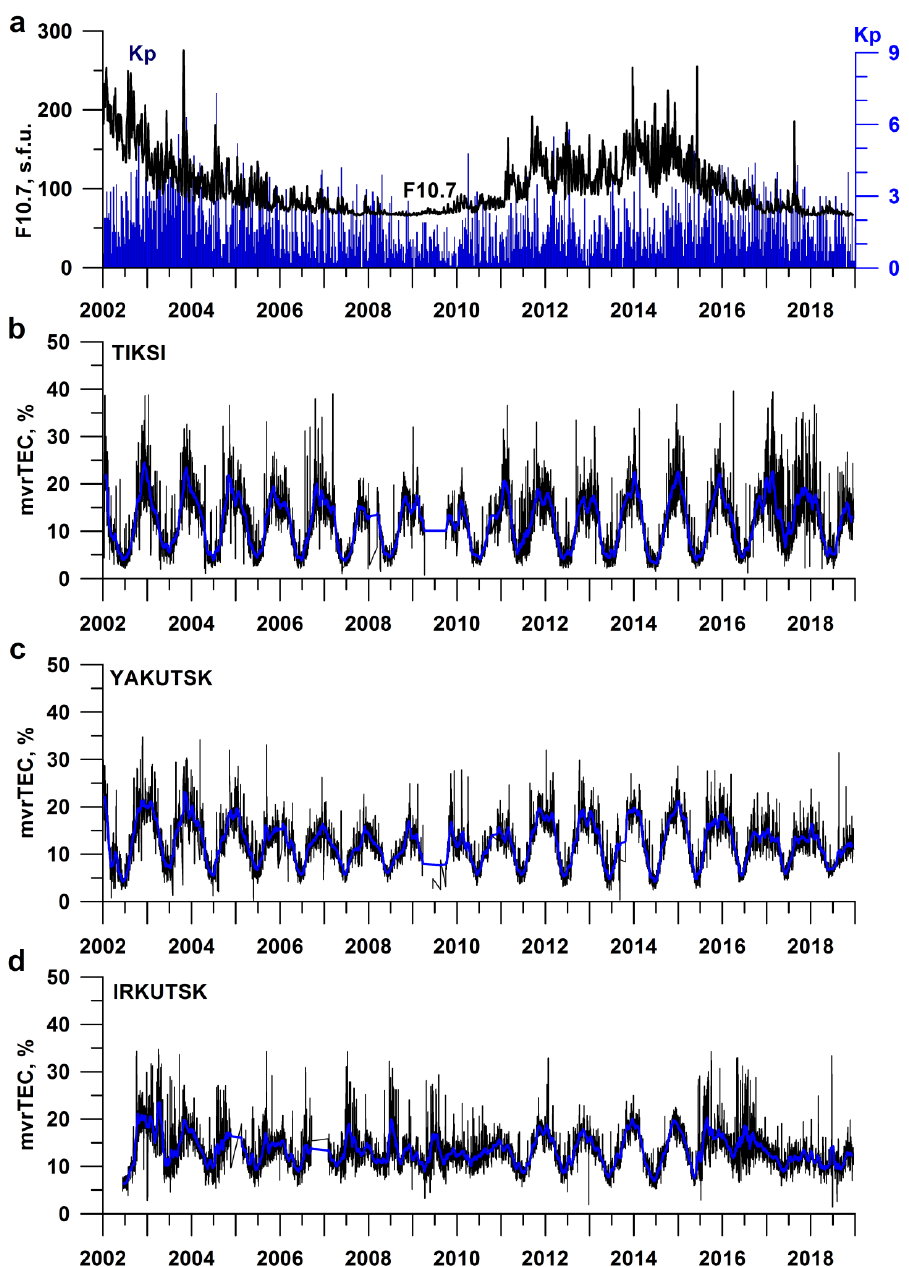
Figure 1. In the F 10.7 and K p ( a ); mvrTEC variations (black), and the 27-day running mean (dark blue) at Tiksi ( b ), Yakutsk ( c ), and Irkutsk ( d ) for 2002-2018.